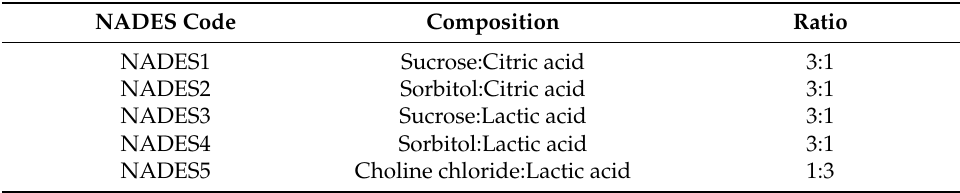
Table 1. NADES used for the extraction of licorice